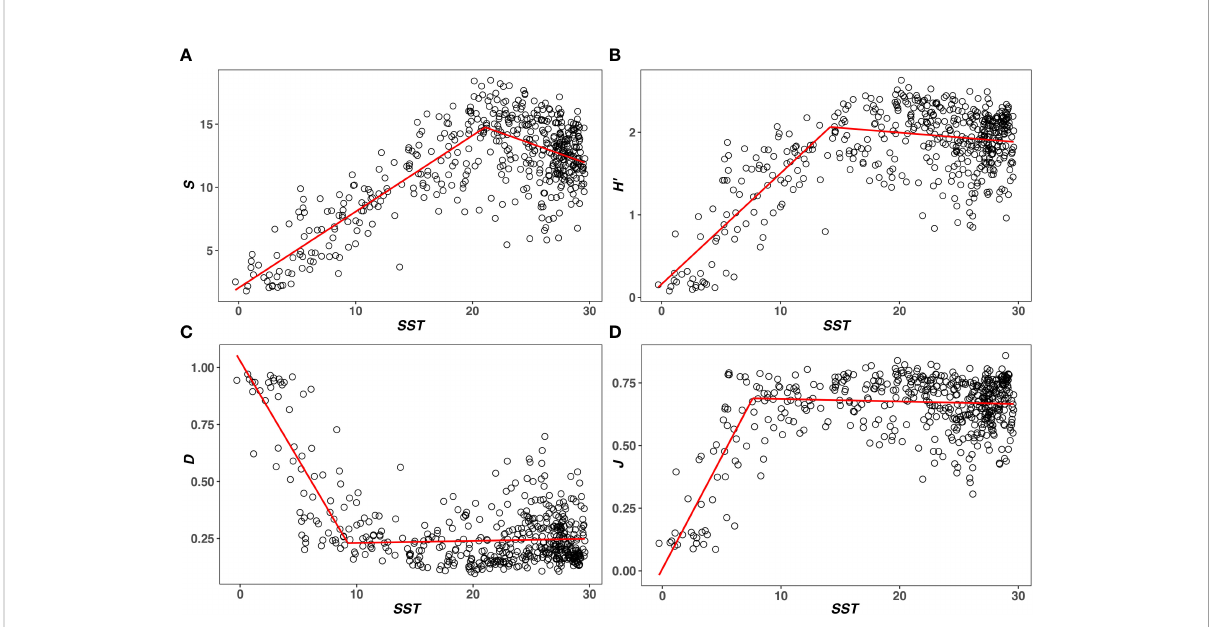
FIGURE 1 The T – diversity relationships are measured by (A) Species Richness ( S ), (B) Shannon ’ s index ( H ’ ), (C) Simpson ’ s index ( D ), and (D) Pielou ’ s evenness ( J ). The red line represents the result of piecewise regression, noting that S , H ’ , D , and J all show a unimodal relationship with